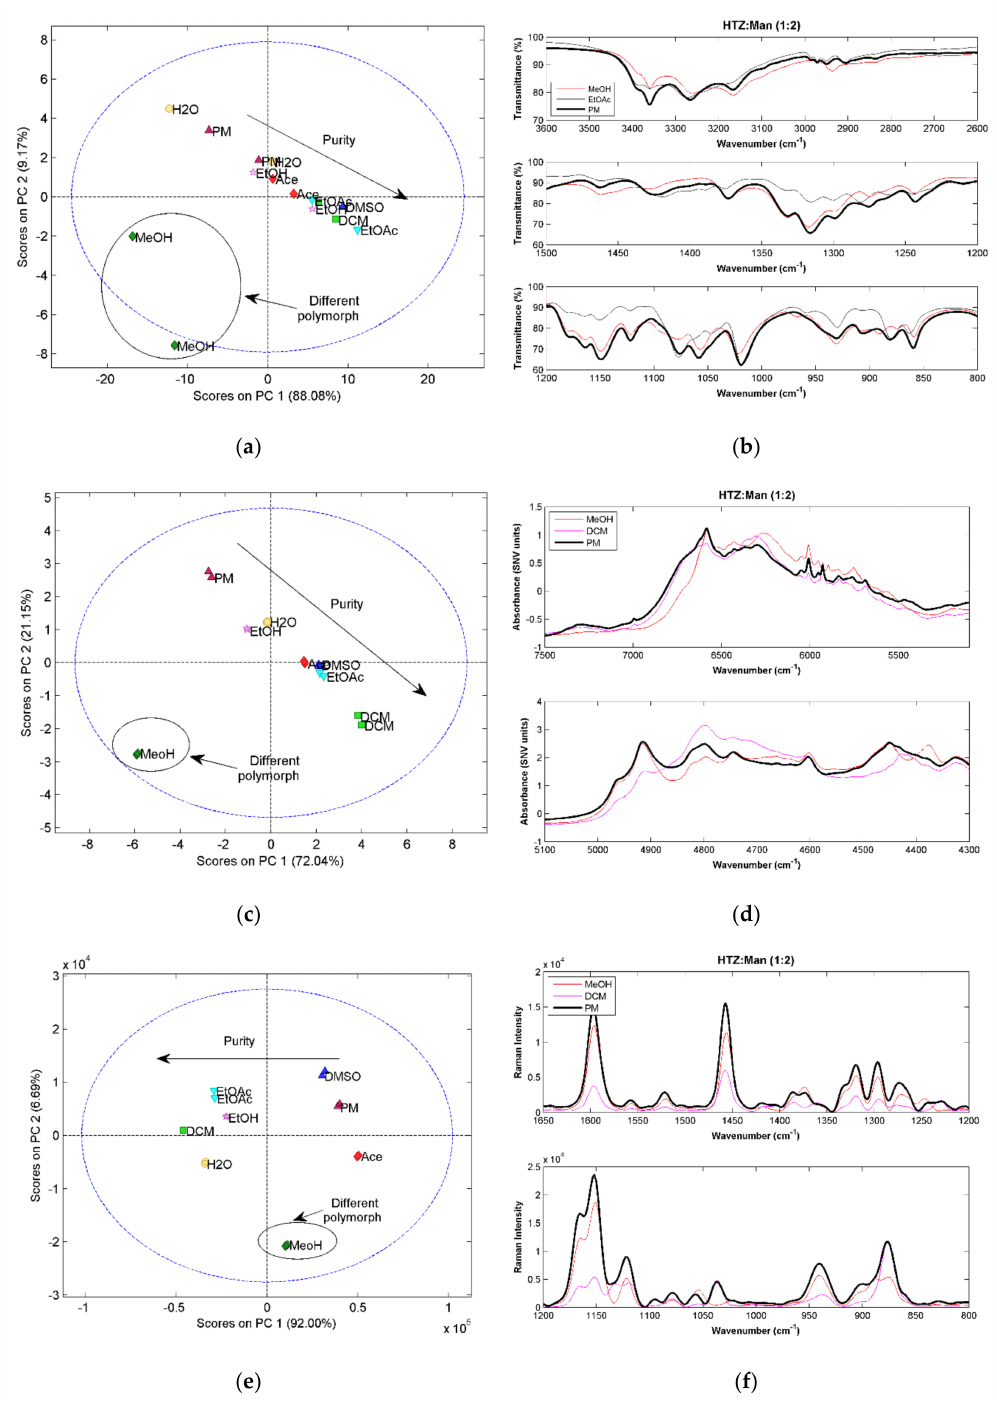
Figure 5. ( a ) PCA score plot constructed with the MIRS spectra from the system HTZ:Man (1:2); ( b ) MIRS spectra of the samples produced with, MeOH and EtOAc and from the PM; ( c ) PCA score plot constructed with the NIRS spectra from the HTZ:Man (1:2); ( d ) NIRS spectra of the samples produced with MeOH and DCM and from the PM; ( e ) PCA score plot constructed with the RS spectra from the HTZ:Man (1:2); ( f ) RS spectra of the samples produced with MeOH and DCM and from the PM. Colors refer to different solvents (dark green: MeOH; pink: EtOH; red: Ace; green: DCM; dark blue: DMSO; blue: EtOAc; yellow: H 2 O; dark red: